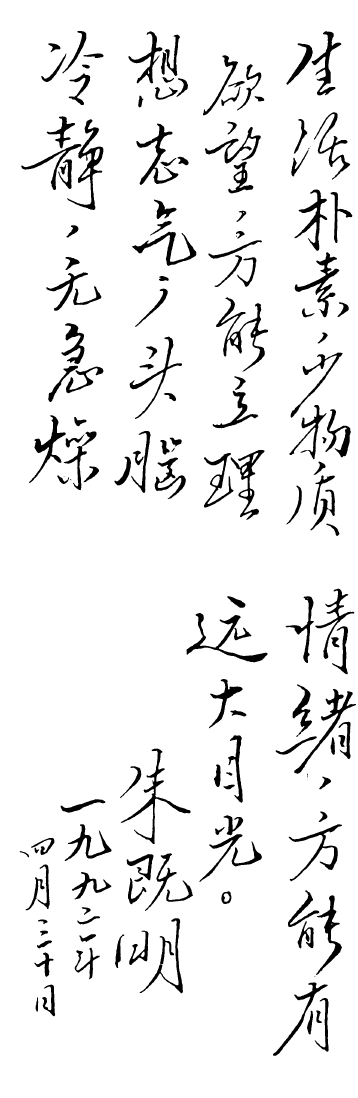
Figure 2. Motto written by Dr. Chi-Ming Chu in